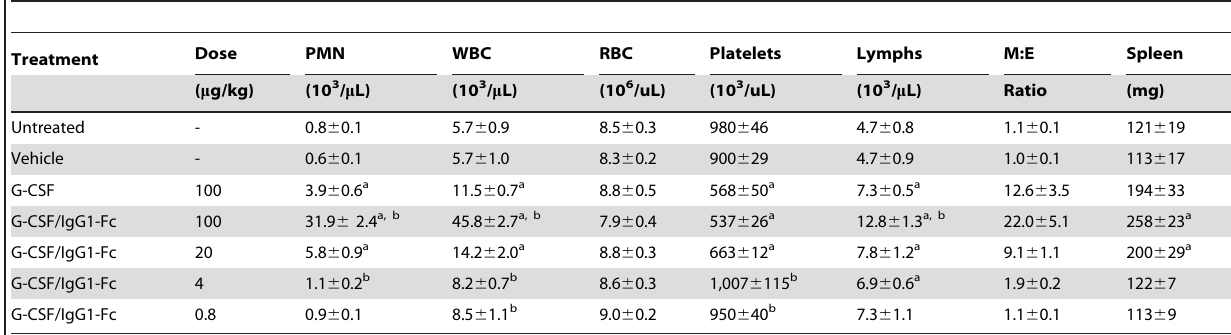
Table 1. Effect of every day (days 1-5) dosing of G-CSF and G-CSF/IgG1-FcL on day 6 blood cell counts in mice.